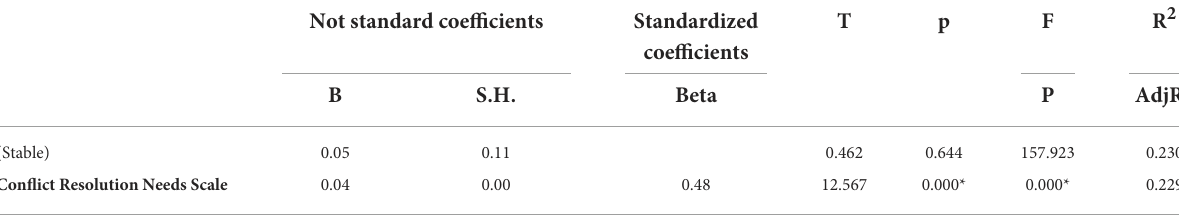
TABLE 4 Prediction of the students’ conflict resolution needs scale scores from the Rosenberg Self-Esteem Scale Scores.